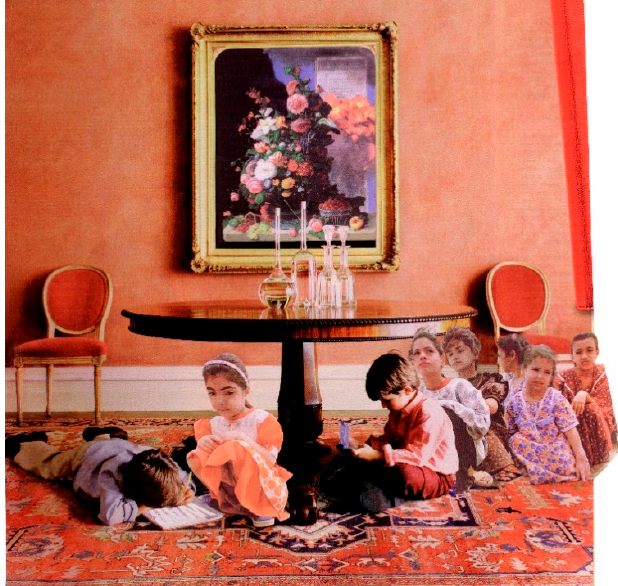
Figure 12. Martha Rosler, Vanitas , from the series House Beautiful: Bringing the War Home, New Series , 2004. Photomontage. © Martha Rosler/Courtesy of the artist and Mitchell ‐ Innes & Nash, New York.